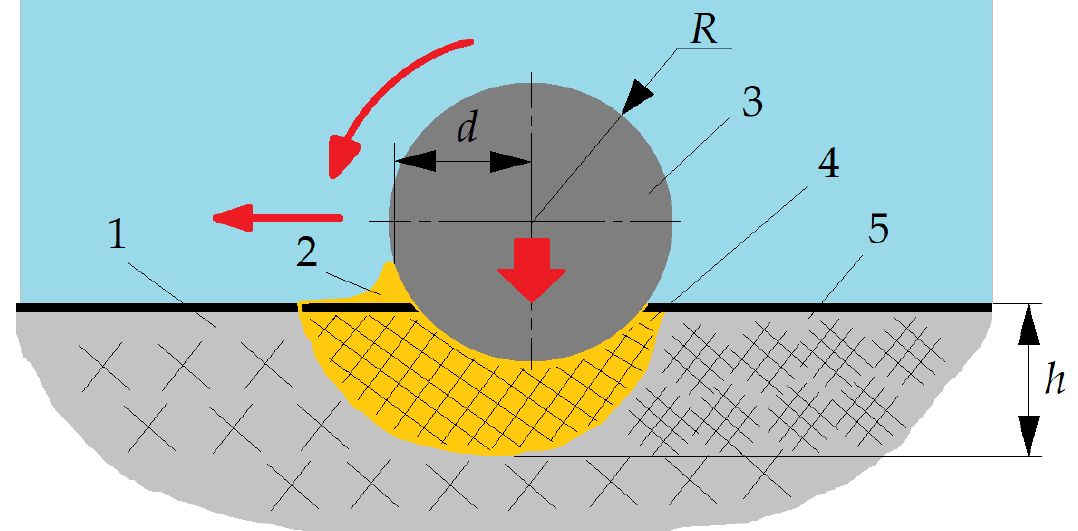
Figure 8. Scheme of surface plastic deformation, where ( 1 ) is the surface to be machined; ( 2 ) is extruded by a roller/tip material at the stage of plastic deformation; ( 3 ) is a roller/tip; ( 4 ) is plastic deformation zone; ( 5 ) is a hardened subsurface layer; R is the radius of a roller; d is feed; h is hardened sublayer depth.